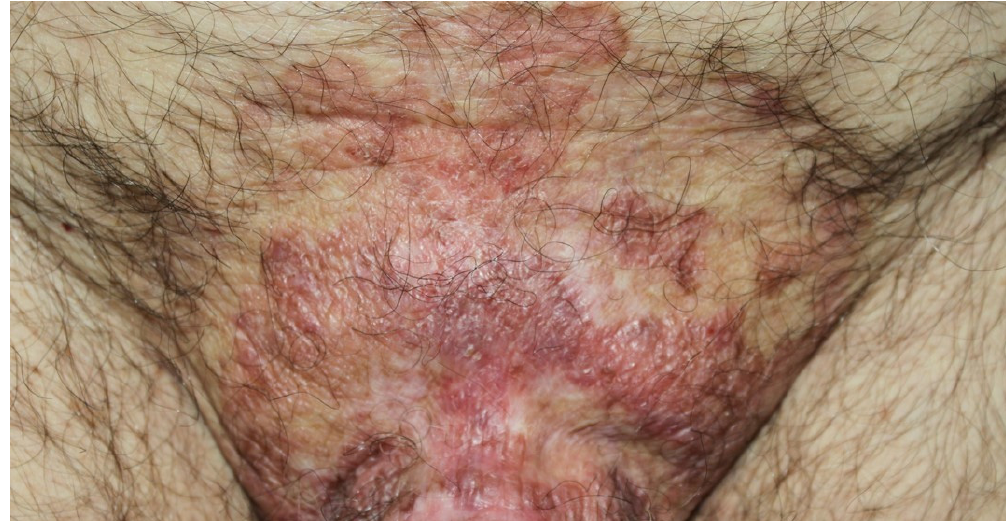
Figure 4. Paraneoplastic pemphigus (lichenoid lesions). Lichenoid lesions on the mons pubis. These kinds of lesions are rare in adults, but they are more often seen in children affected by paraneoplastic pemphigus.